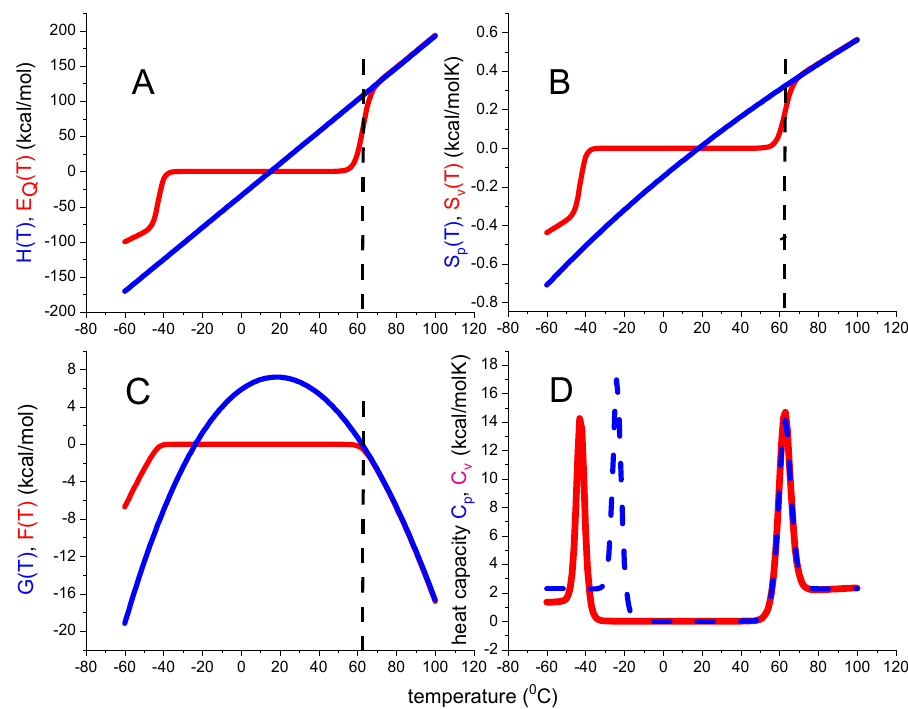
Figure 4. Statistical–mechanical two-state model. Red lines calculated with ∆ E 0 = 110 kcal/mol and C v = 1.05 kcal/molK. ( A ) Inner energy ∆ E(T). ( B ) Entropy ∆ S v (T). ( C ) Helmholtz energy ∆ F(T). ( D ) Heat capacity C p (T). Blue lines are calculated with the standard chemical equilibrium two-state model, using, ∆ H 0 = 107 kcal/mol, ∆ C 0 p = 2.27 kcal/molK. Dashed vertical lines: midpoint tempera- ture T m = 62 °C.